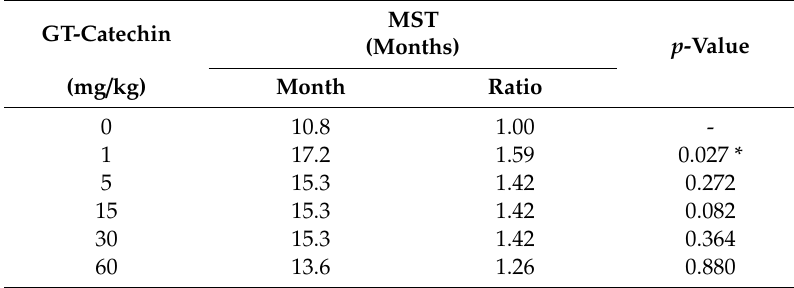
Figure 1. E ff ect of catechin ingestion on longevity of SAMP10 mice that consumed GT-catechin in water from 1 month of age. GT-catechin solution was freshly prepared twice a week. Three groups of 36 mice each consumed 0 (control), 15, and 60 mg / kg of GT-catechin. Another 3 groups of 24 mice each consumed 1, 5, and 30 mg / kg of GT-catechin. Table 1. E ff ect of green tea catechin (GT-catechin) ingestion on median survival time (MST) of senescence-accelerated mouse prone 10 (SAMP10)